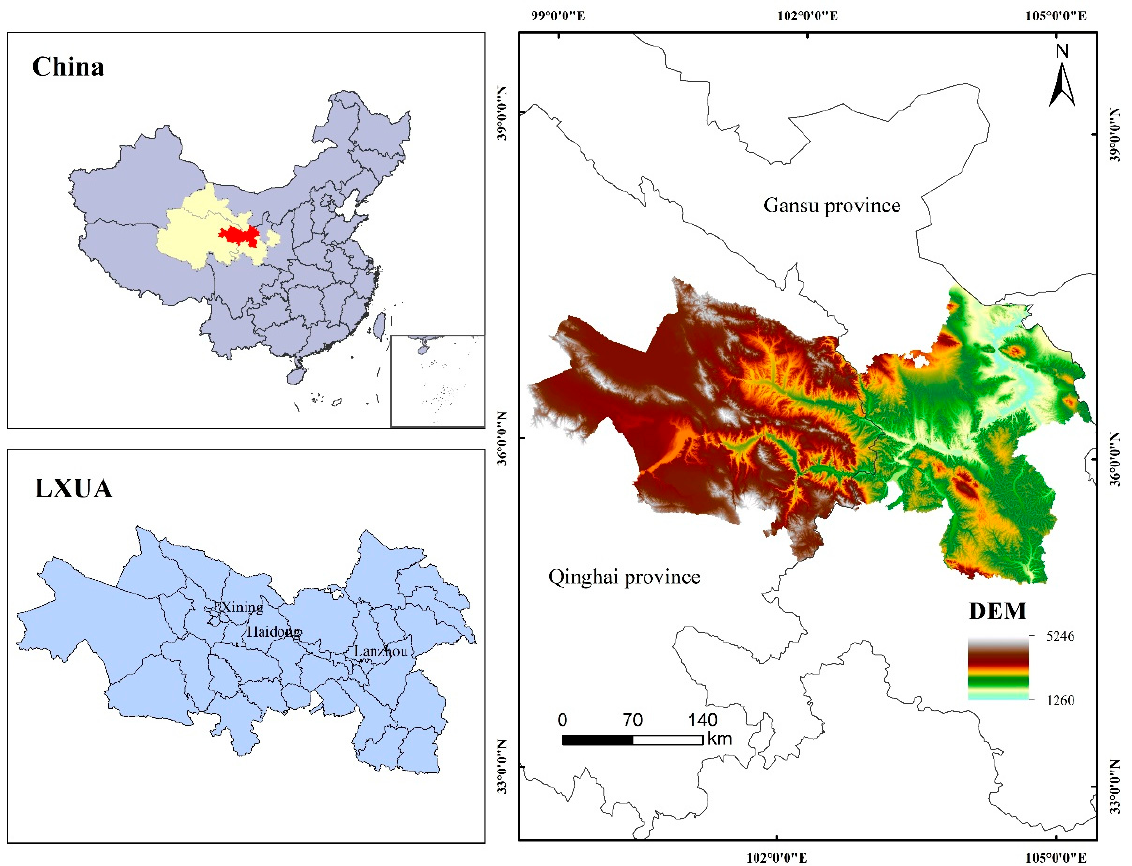
Figure 1. The location map of the study area. Table 1. The administrative divisions of the research area.